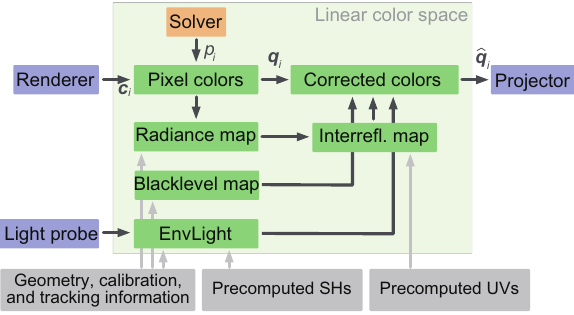
Fig. 5 An overview of the